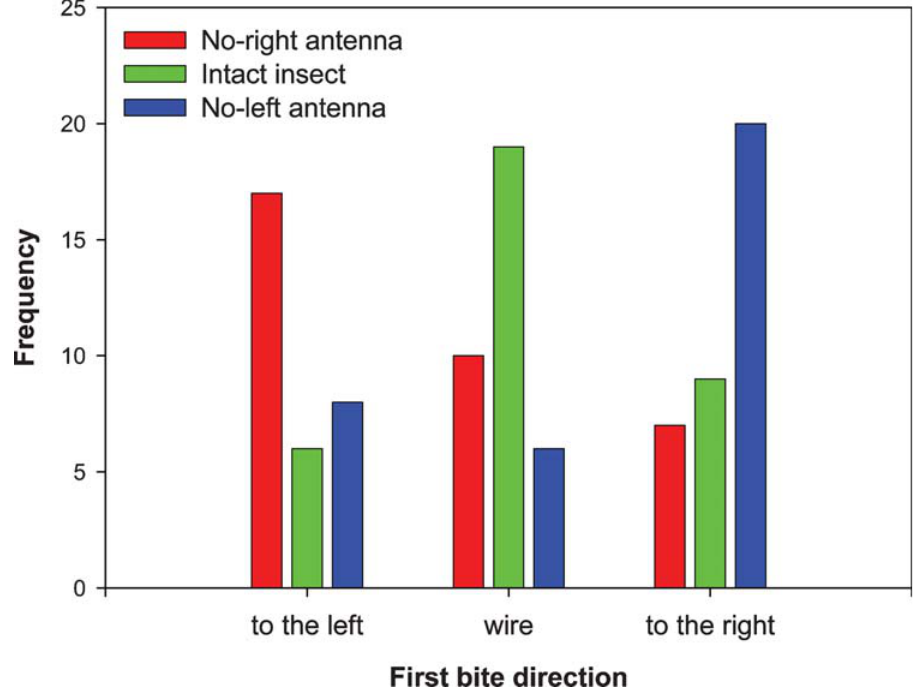
Figure 3. Distribution of first bites (i.e., the first contact of each insect with the source) performed by intact (n=34) and unilaterally antennectomized bugs (n=34 left + 34 right) in relation to the position of the heated wire. Only intact insects directed their bites correctly towards the heat source, whereas bugs lacking one antenna missed the goal and addressed their bites in the direction of the remaining antenna. Fully antennectomized insects (n=20) did not respond at all and for this reason they have not been included in the plot.